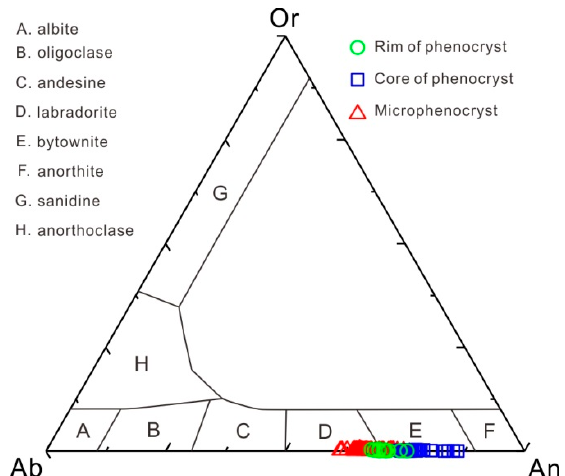
Figure 8. Or–Ab–An classification diagram of plagioclase phenocrysts and microphenocrysts.